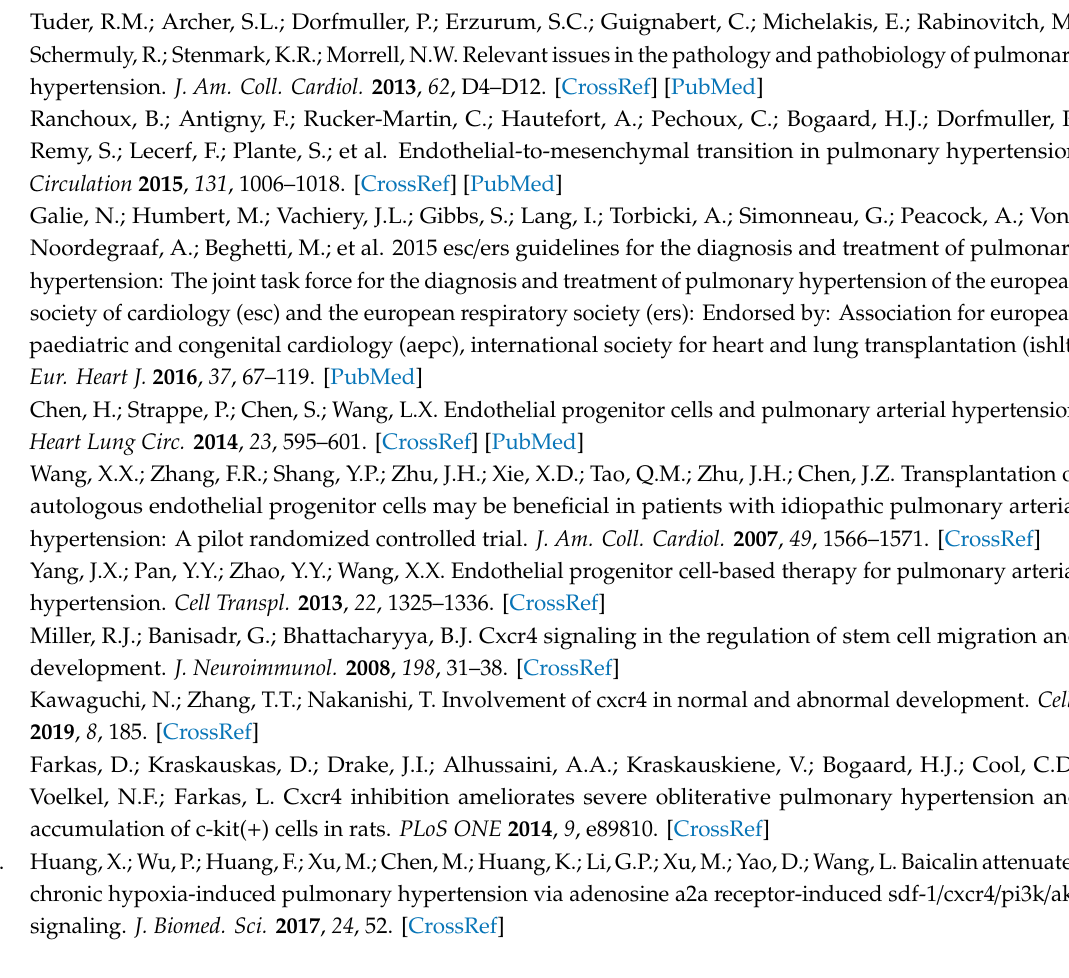
Figure S1: Graphical representation of BMC preparation. Figure S2: Comparison of gene expression levels of stem cell related markers and inflammatory markers between control and silibinin treatment groups of normal samples, Figure S3: FCM evaluation of CXCR4 in normal rats using Moflo. Table S1. Primers used for real-time